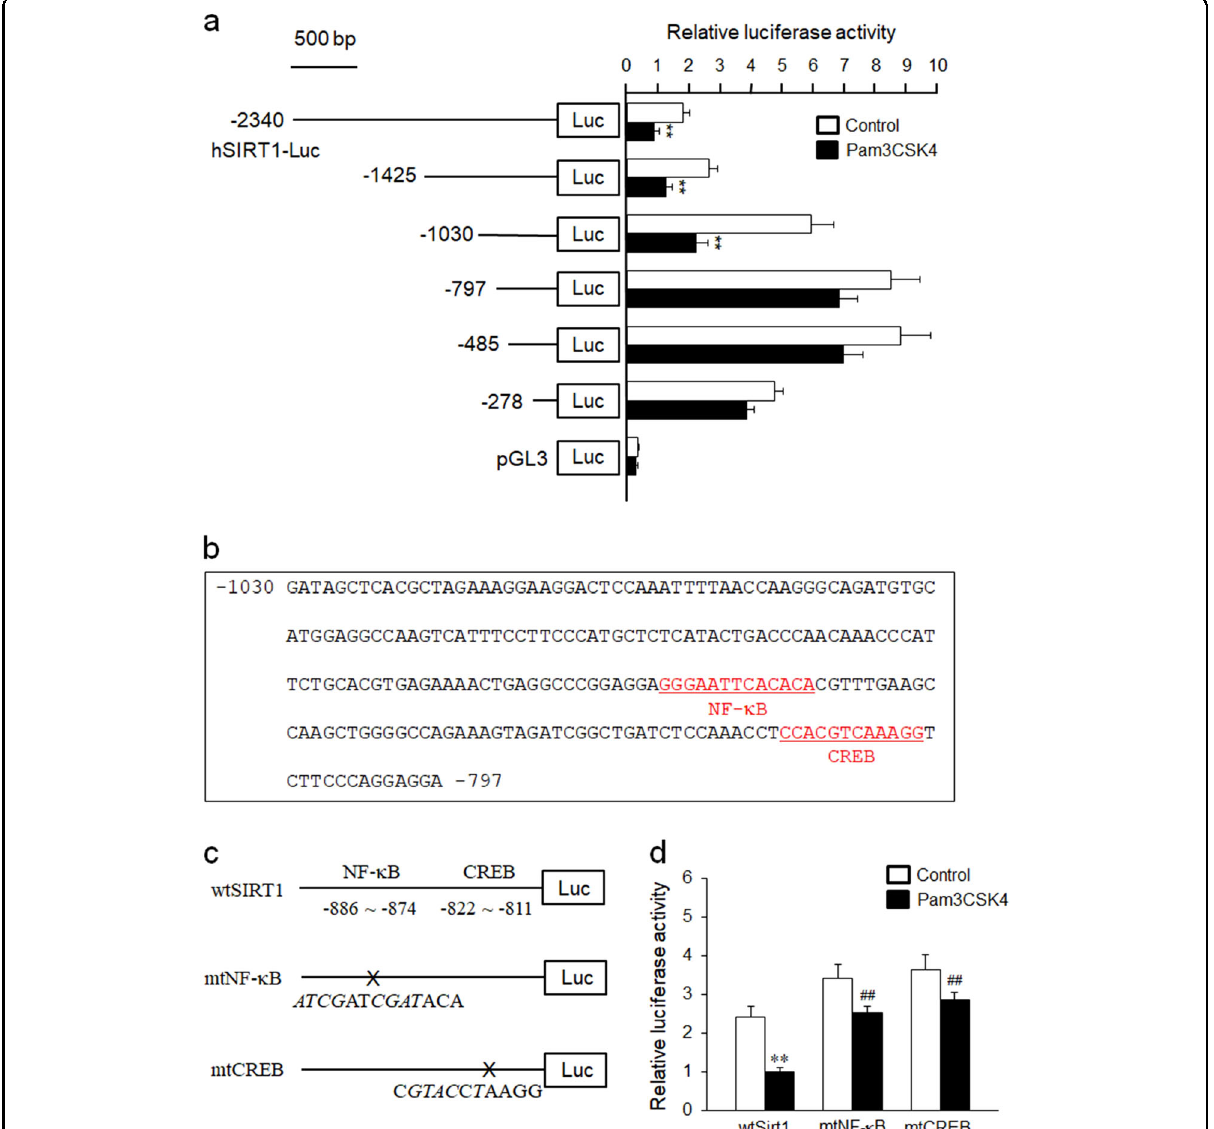
Fig. 5 Characteristics of the SIRT1 promoter region involved in Pam3CSK4-mediated downregulation of SIRT1 transcription. a THP-1 cells were transiently cotransfected with various promoter constructs and an empty luciferase vector pRL CMV for 24h, and then stimulated with 100ng/mL Pam3CSK4 for 24h. Relative luciferase activities are presented as the means± SEM of fi ve independent experiments. ** P < 0.01 compared with the value for the corresponding control. b Nucleotide sequence of the promoter region of the SIRT1 gene. The sequence of the region between nt − 1030 and − 797 bp of the 5 ′ - fl anking region is shown. The underlined sequences are possible transcription factor-binding sites predicted by TFsearch. c , d THP-1 cells were cotransfected with the empty luciferase vector pRL CMV and promoter constructs containing the WT and mutant constructs of the NF- κ B and CREB-binding sites for 36h (wtSIRT1, wild-type pSIRT1-1030; mtNF- κ B, NF- κ B mutant; mtCREB, CREB mutant), and then stimulated with 100 ng/mL of Pam3CSK4 for 24h. Relative luciferase activity is presented as the mean values± SEM of fi ve independent experiments. **P < 0.01 compared with the corresponding control; ## P < 0.01 compared with the corresponding value for